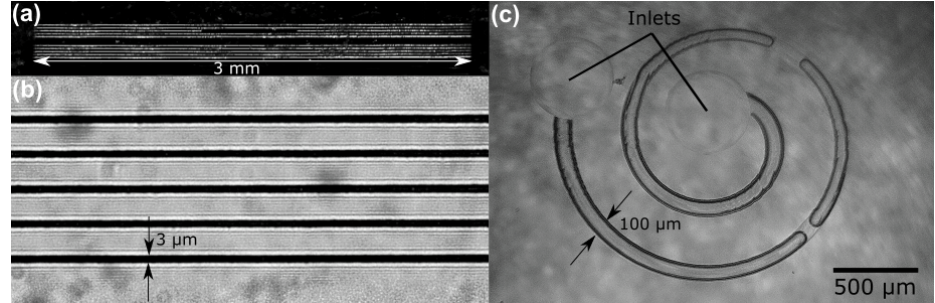
Figure 6. ( a , b ) Enhanced contrast pictures of straight-through high aspect ratio (1:1000) channels embedded inside fused silica. ( c ) microfluidic system within the volume of glass, consisting of two outlets and a spiral channel. All of the structures are etched using the best KOH and isopropanol ratio solution (2 mol/L and 10%